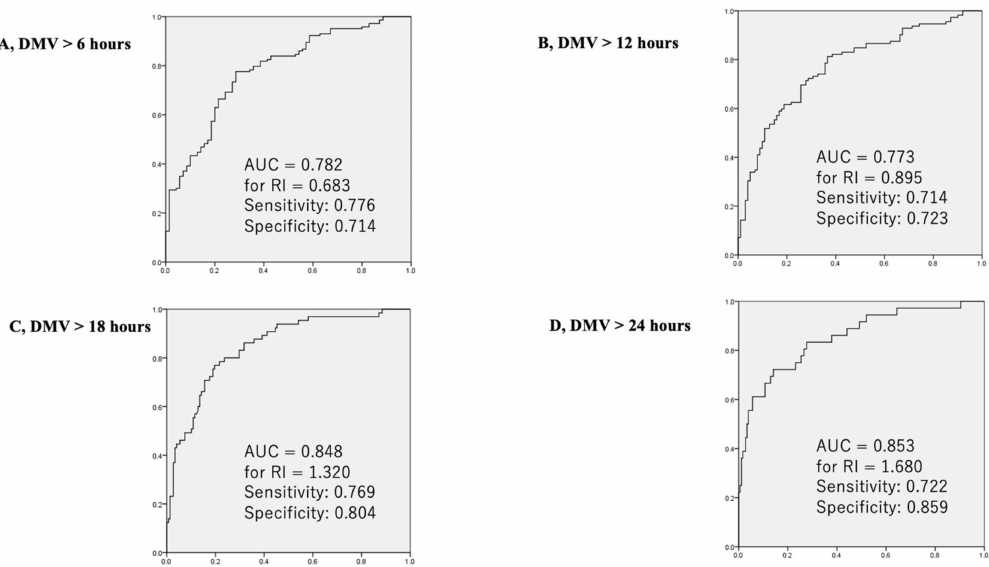
Figure 5. Receiver operating characteristic (ROC) curves for the respiratory index as a predictor of the duration of mechanical ventilation shorter than 6 h ( A ), 12 h ( B ), 18 h ( C ), and 24 h ( D ) are presented. ( A ) RI < 0.683 showed the highest sensitivity (0.776) and specificity (0.714) with an area under the curve of 0.782. ( B ) RI < 0.895 showed the highest sensitivity (0.714) and specificity (0.723) with an area under the curve of 0.773. ( C ) RI < 1.320 showed the highest sensitivity (0.769) and specificity (0.804) with an area under the curve of 0.848. ( D ) RI < 1.680 showed the highest sensitivity (0.722) and specificity (0.859) with an area under the curve of